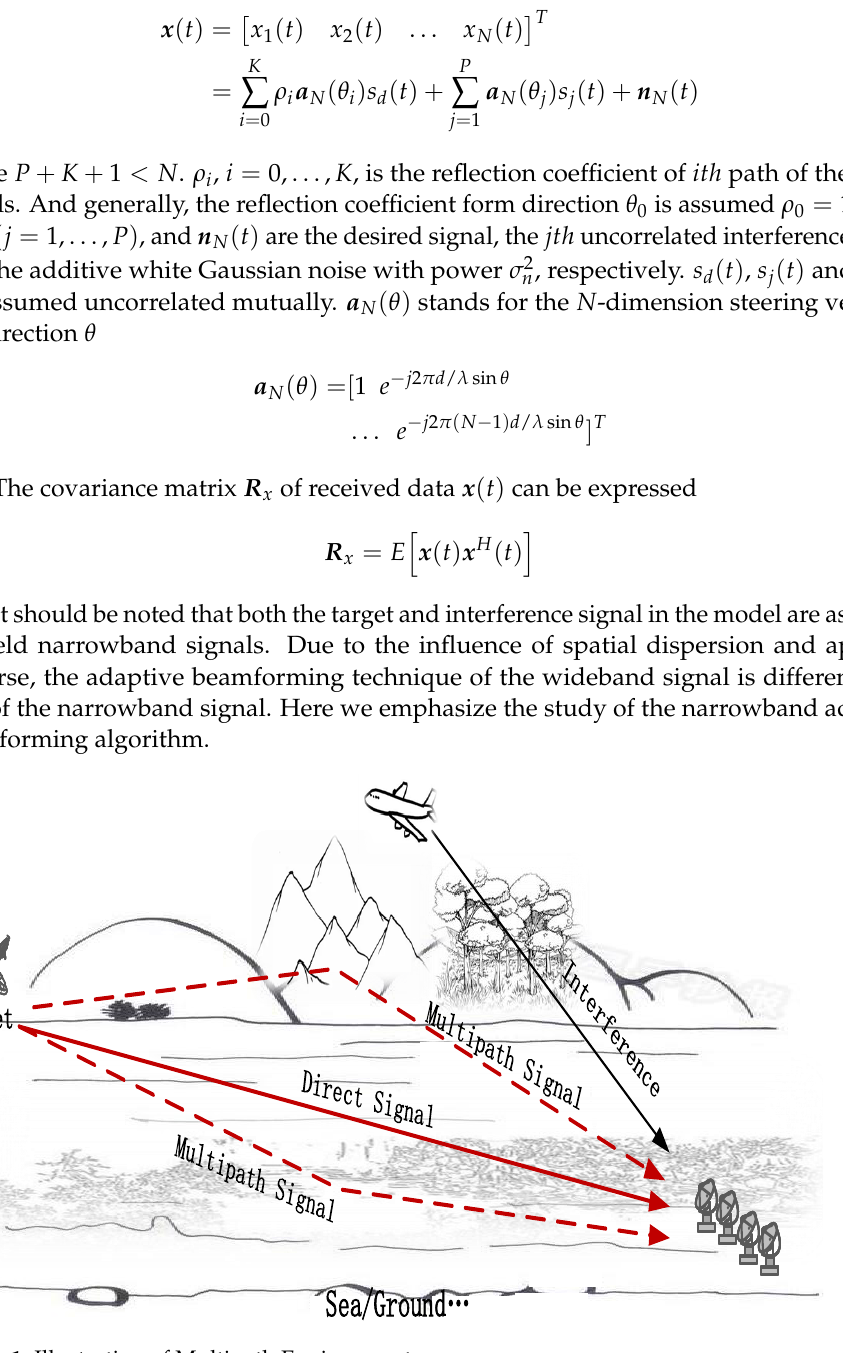
Figure 1. Illustration of Multipath